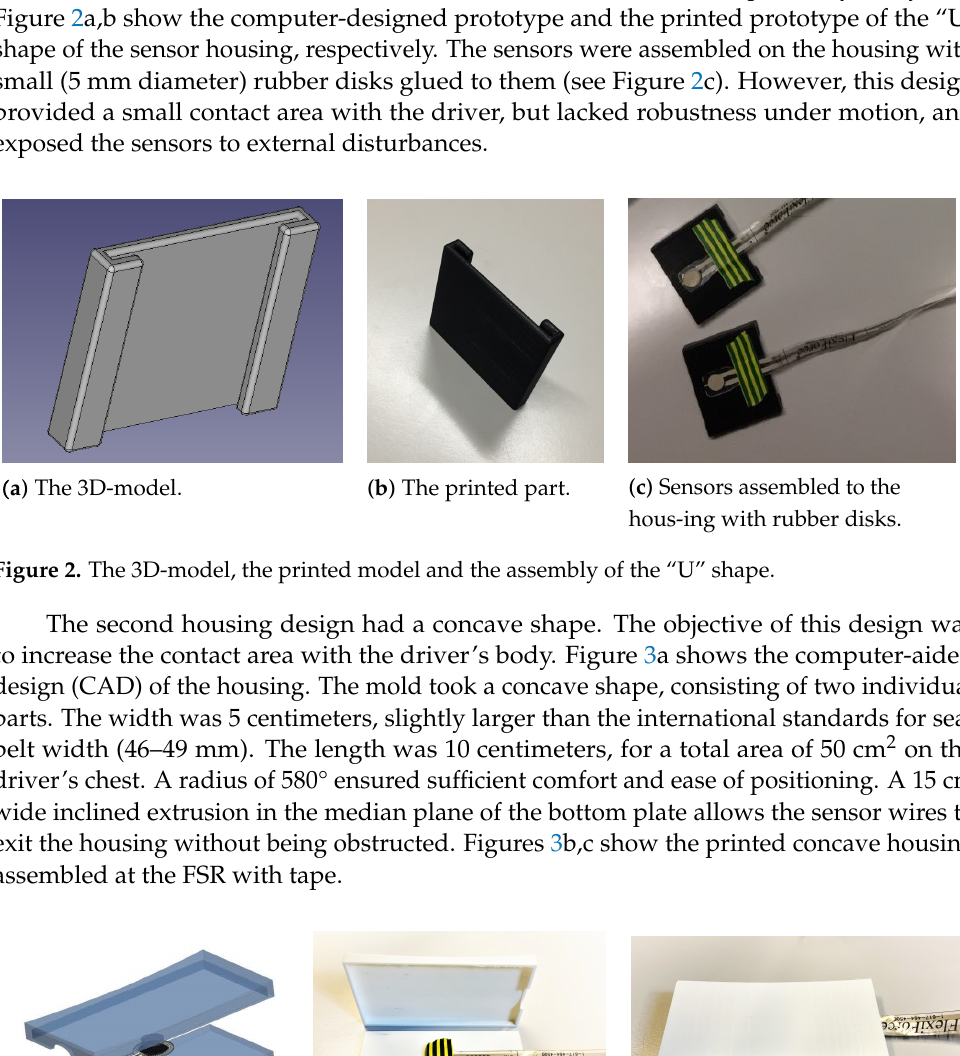
Figure 3. The 3D-model and the printed model of the concave shape, assembled with the sensors.